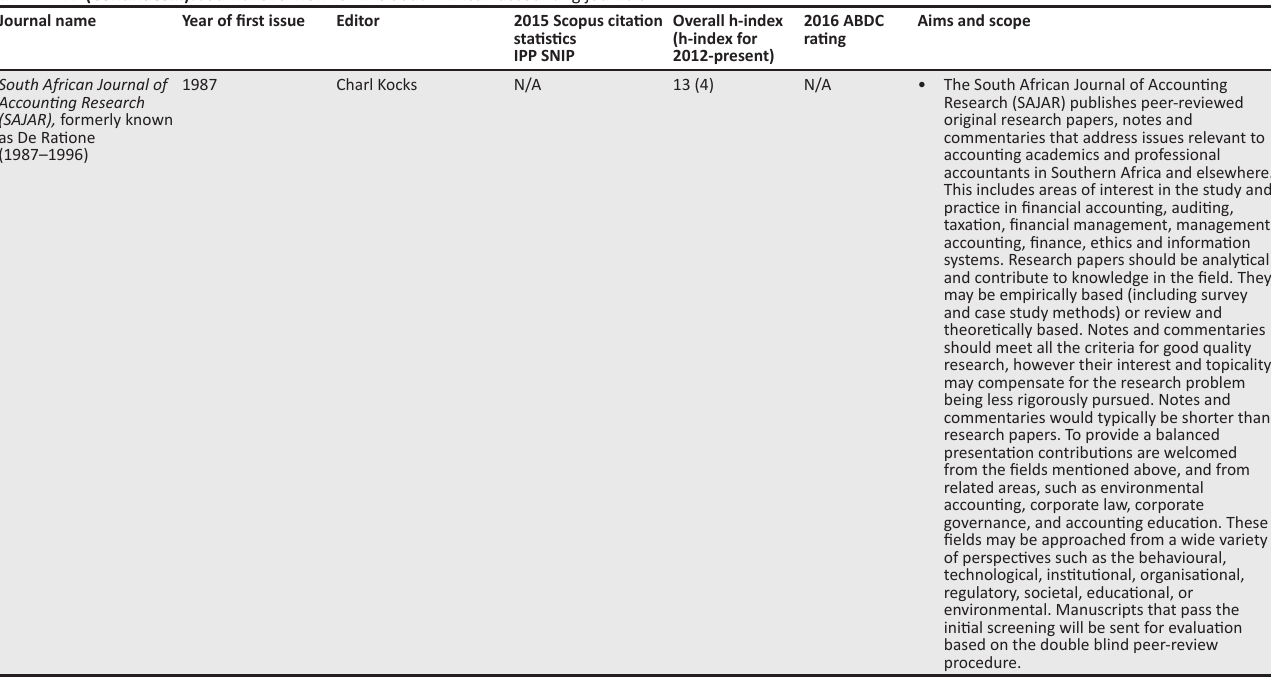
TABLE 1-A1(Continues...): Journal overview for five South African accounting